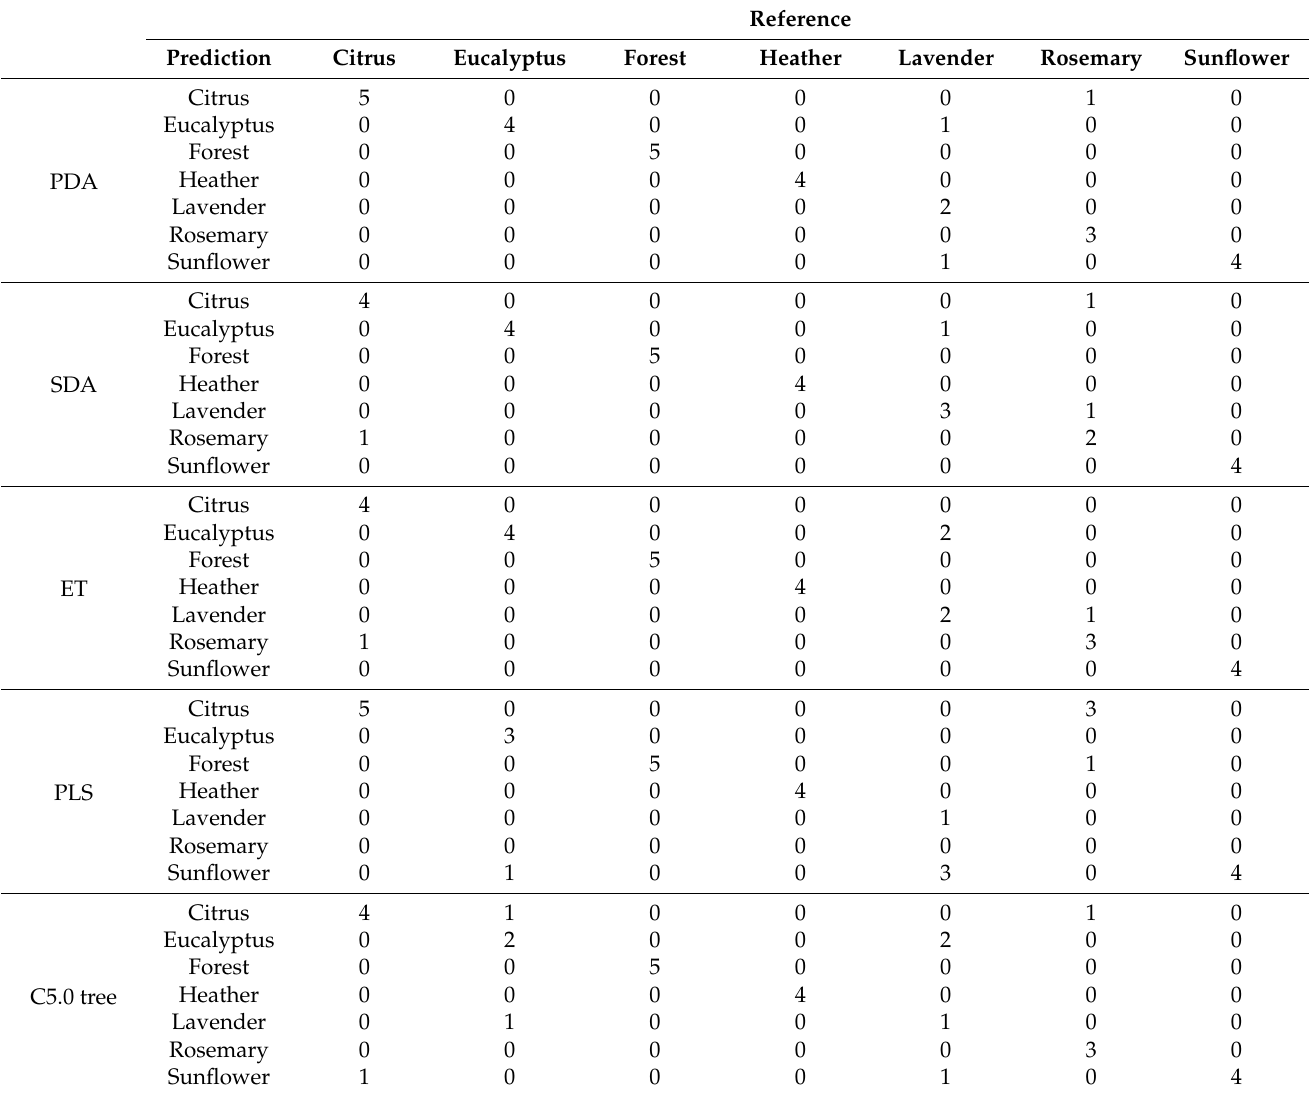
Table 2. Confusion matrices of various classifier algorithms (PDA, SDA, ET, PLS, C5.0 tree) on the test set. The number of honey samples in this set was as follows: citrus (5), eucalyptus (4), forest (5), heather (4), lavender (4), rosemary (4) and sunflower